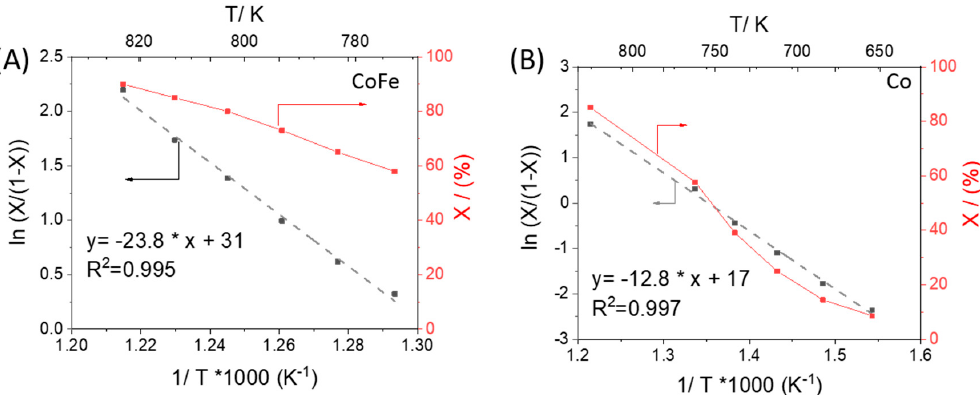
Figure 5. Arrhenius plot (assuming first order reaction) and conversion when ammonia is pulsed over ( A ) CoFe and ( B ) Co samples at different temperatures; X is NH 3 conversion, the apparent rate constant is proportional to X/(1-X); see derivation in [31] .